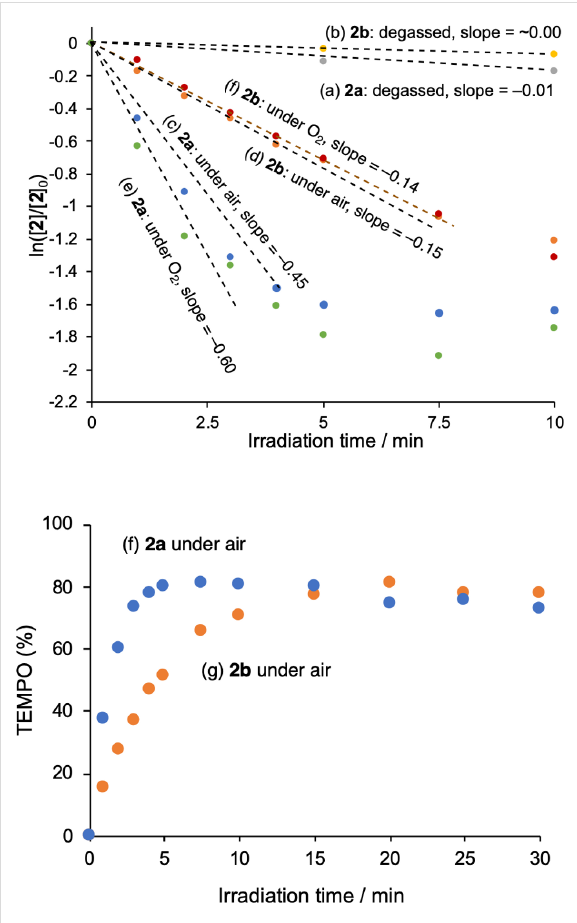
Figure 2: Time profile for photochemical generation of TEMPO radical from 2 (5 mM) at ≈ 298 K in benzene: (a) from 2a under degassed conditions, (b) from 2b under degassed conditions, (c,g) from 2a under air conditions, (d,h) from 2b under air conditions, (e) from 2a under O 2 , (f) from 2b under O 2